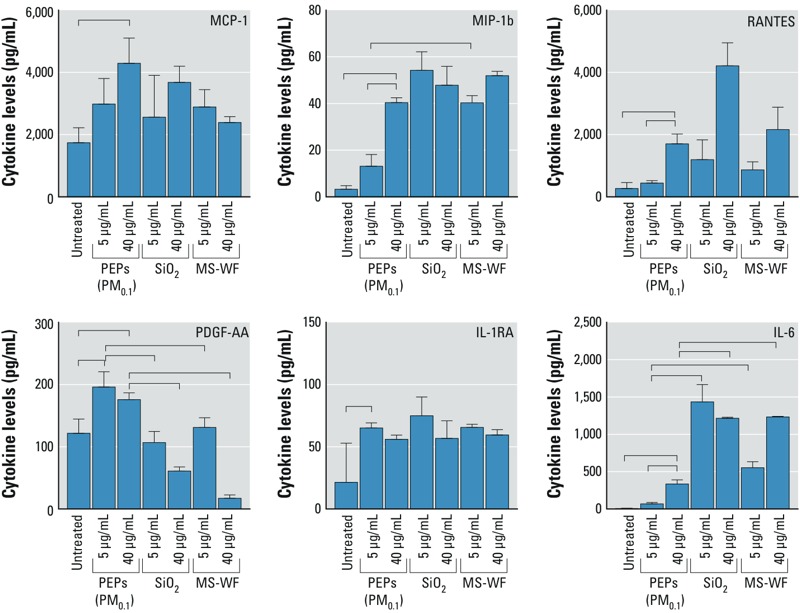
Measured levels of cytokines and chemokines in supernatant of SAECs exposed to PEPs, SiO2, and MS-WF for 24 hr. All values are represented as the mean ± SE. Bar represents a significant difference in measurements across the treatment groups with p < 0.05.